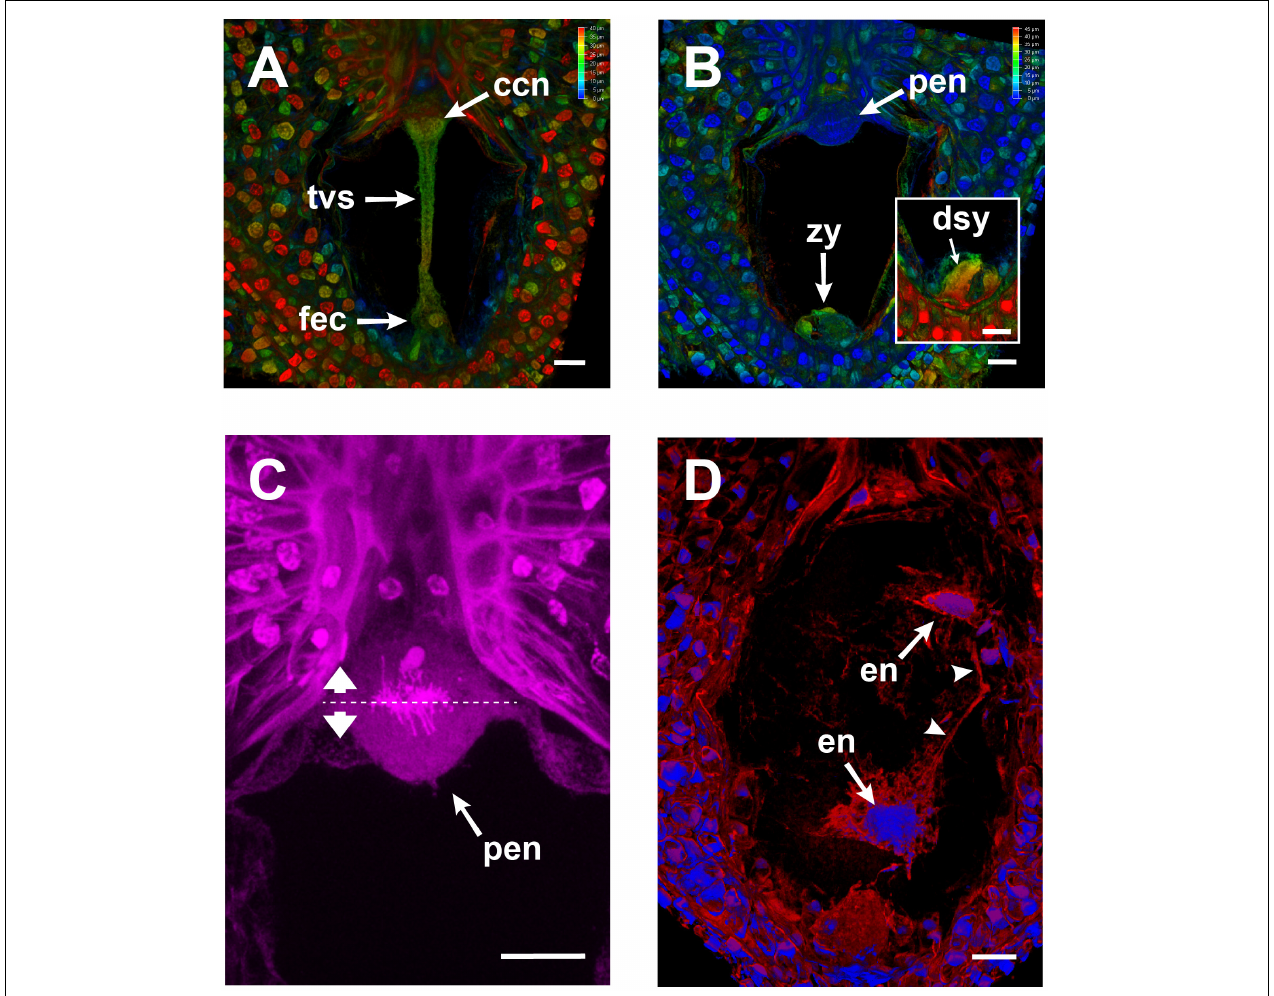
FIGURE 6 | Changes in the embryo sac of Agave inaequidens after karyogamy and early endosperm development (44–48 HAP). (A,B) Color-coded projection of z-stacked micrographs of similar thickness from Feulgen-stained fertilized ovules. (A) A transvacuolar strand connected the chalazal and micropylar poles right after karyogamy of the egg and central cells. (B) The transvacuolar strand was no longer detectable before the primary endosperm nucleus divided. (C) Close up of the primary endosperm nucleus at anaphase; the dashed line shows the division plane. (D) F-actin (red) surrounded and connected (arrowheads) each nucleus (blue) of the developing endosperm in the coenocyte. F-actin was stained with rhodamine-phalloidin; nuclei were stained with Hoechst 33258. ccn, central cell nucleus; tvs, transvacuolar strand; fec, fertilized egg cell; zy, zygote; dsy, degenerated synergid; pen, primary endosperm nucleus; en, endosperm nuclei. Micrographs are z-stack projections oriented with the chalazal pole at the top. Bar in (A–D) = 20 µ